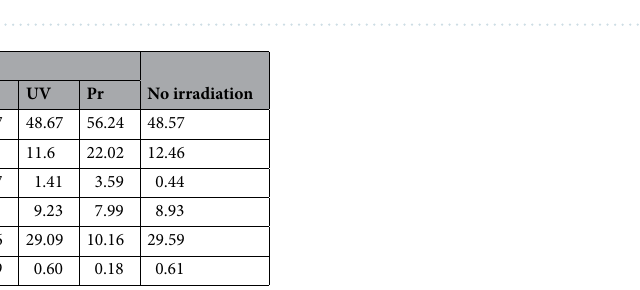
Figure 8. TOF-SIMS spectra of ILs after irradiations.